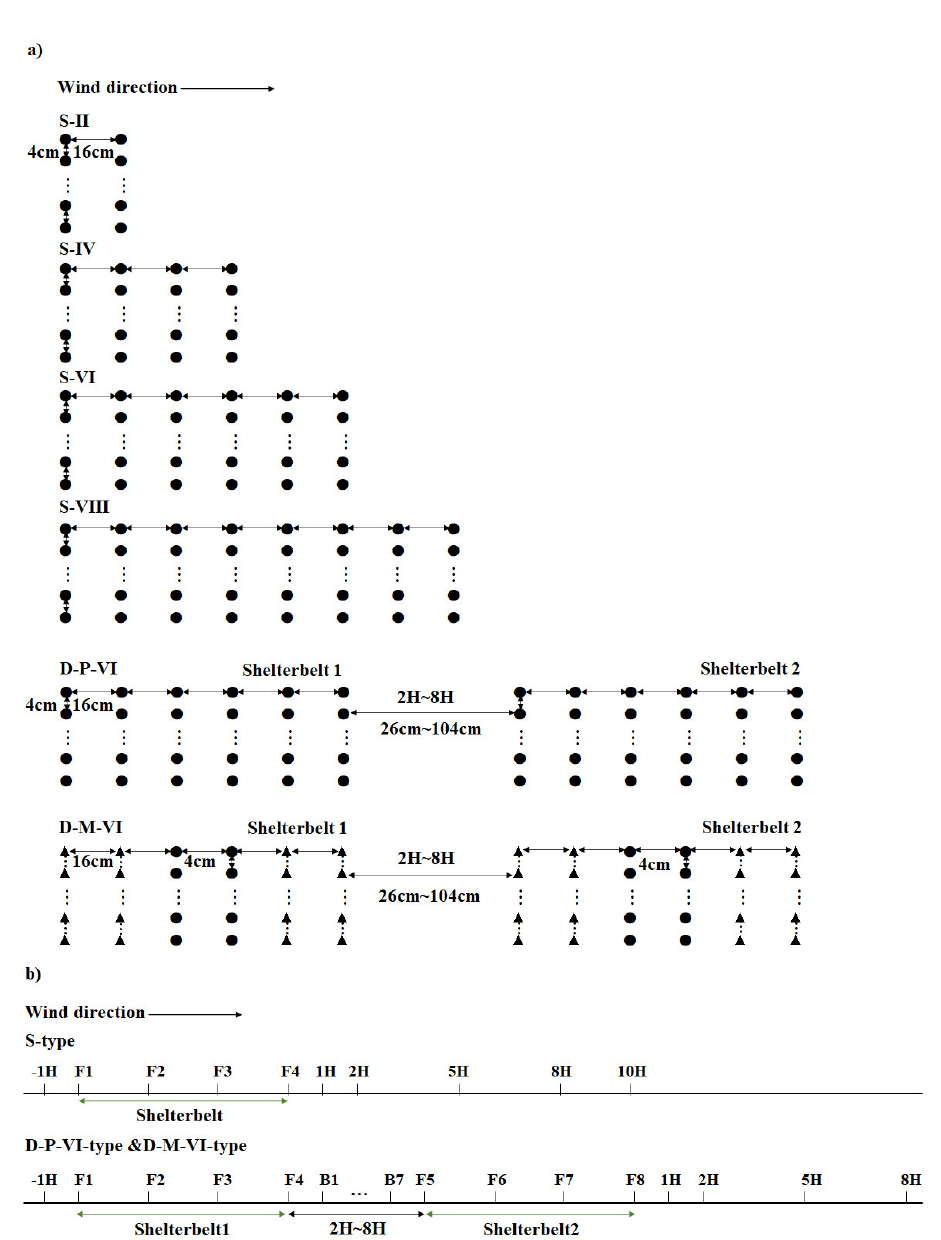
Figure 2. Design of the shelterbelt model and distribution of the wind speed observation points. Sub- figure ( a ) shows the different configuration modes of the shelterbelt ( • arbor; (cid:78) shrub). Sub-figure ( b ) shows the distribution of the wind speed observation points of three types of shelterbelts (S-type represents the single shelterbelt with different rows; D-P-VI-type represents double pure shelterbelts comprising arbors; D-M-VI-type represents double mixed shelterbelts comprising arbors and shrubs, and VI represents the number of rows in each shelterbelt; H represents the height of the